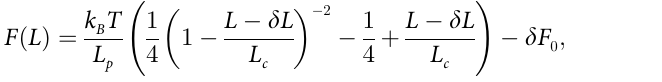
A fi rst set concerns the number of successful elongation data for the entire campaign of experiments. A second set provides the value of persistence length L p extracted from fi tting Eq [1] to elongation curves under different conditions of medium (PBS and PBS+1.5 – 30 μ M BSA). When elongation curves cannot be obtained (strong attachment or no interaction), the attempt was reported as “ failed ” . The distribution of L p exhibited four distinct modalities. Each peak was fi tted with either Gaussian function or deconvoluted using multipeak convergence and reported in this table. ( * ) indicates failure in multipeak fi tting convergence. Values are only the position (in nm) of the highest